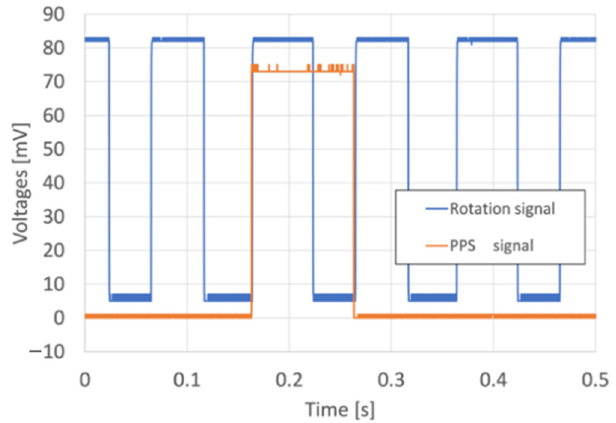
Figure 3. Example of a rotation signal from a proximity sensor (blue line) and PPS signal from GPS module (orange line).